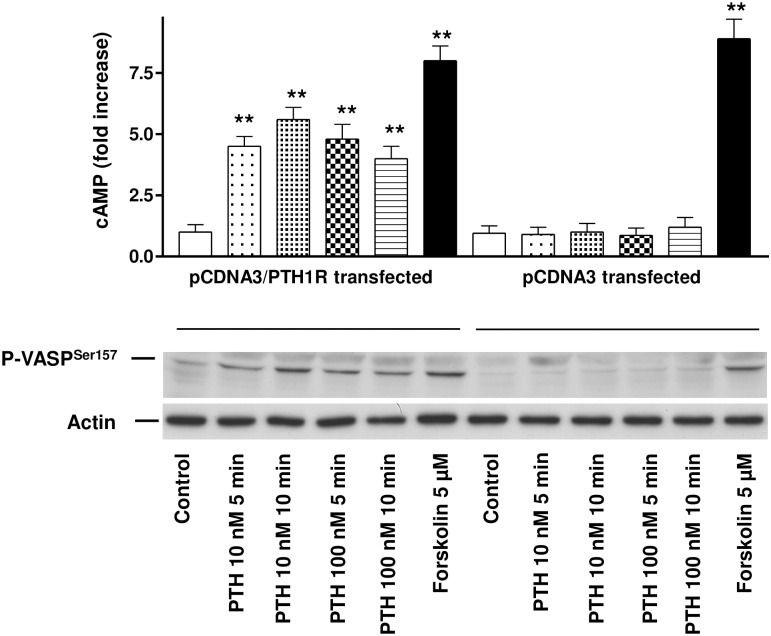
Activation of PTH1R by PTH in PTH1R transfected HEK293 cells increases intracellular cAMP and induces PKA-triggered VASP phosphorylation.The upper panel depicts cAMP increase in HEK293 cells transfected with PTH1R (pcDNA3/PTH1R transfected) or with the vector only (pcDNA3 transfected). Cells were stimulated for up to 10 min with 10 or 100 nM PTH as indicated. For PTH-independent positive control cells were stimulated by 5 μM forskolin (as depicted). Data of thee independent experiments are presented as mean ± SEM, n = 3, p< 0.05 compared to the pcDNA3 control. Phosphorylation of VASP and loading control were documented by Western immunoblots with specific antibodies as indicated in the lower panel.